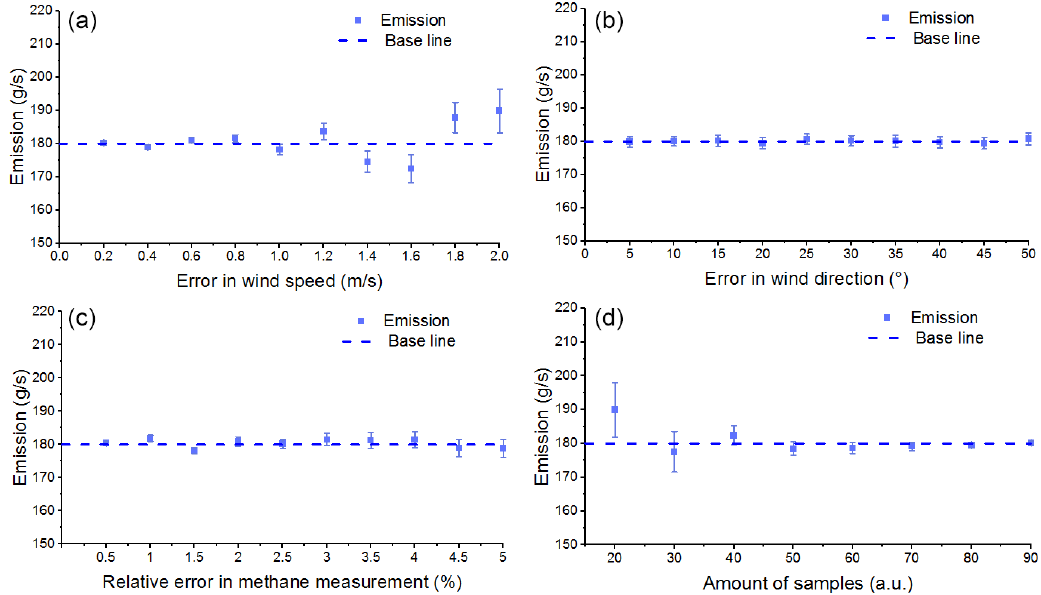
Figure 8. Influence of accuracy of parameters on retrieved emission results. The baseline represents the emission rate setting of CH 4 , 300gs − 1 : (a) wind speed, with additional error ranging within 0.2–2ms − 1 and an interval of 0.1ms − 1 , (b) wind direction, with additional error ranging within 5–50 ◦ and an interval of 5 ◦ , (c) accuracy of CH 4 samples, with additional error ranging within 0.5%–5.0% and an interval of 0.5%, and (d) number of CH 4 samples, randomly selected as 20–90 among the defined 99